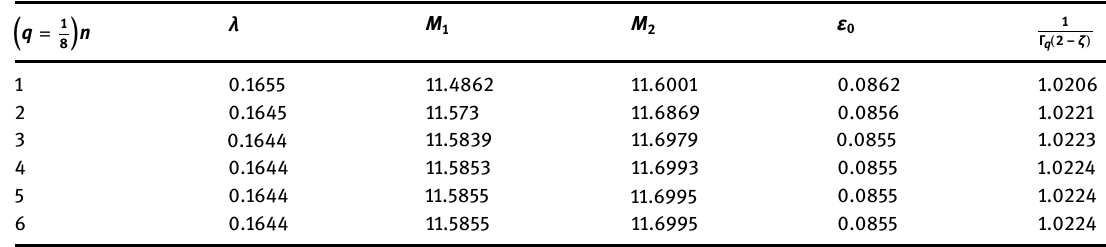
Table 6: Some numerical results of λ , M 1 , M 2 , ε 0 ,